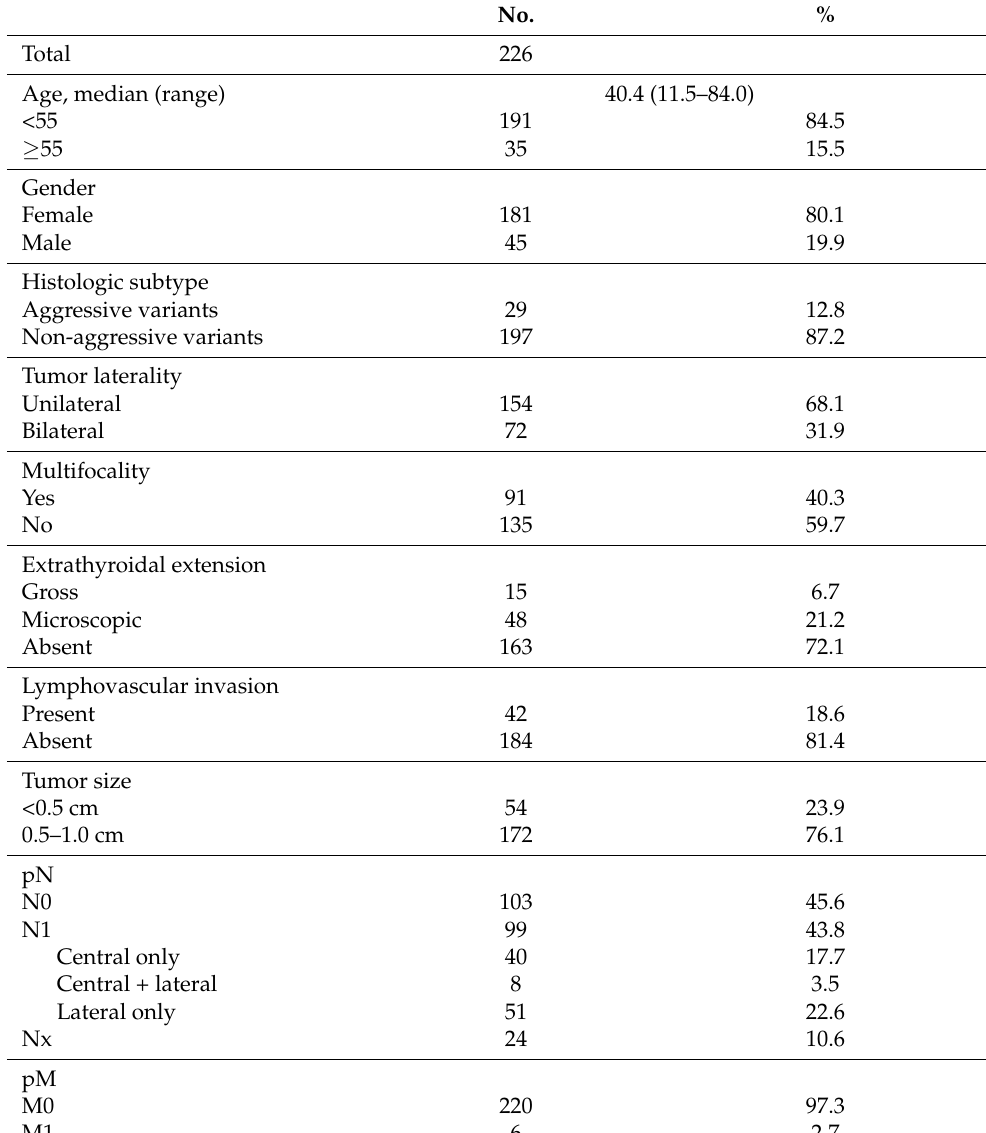
Table 1. Clinico-pathological and molecular characteristics of papillary thyroid microcarcinoma. No.